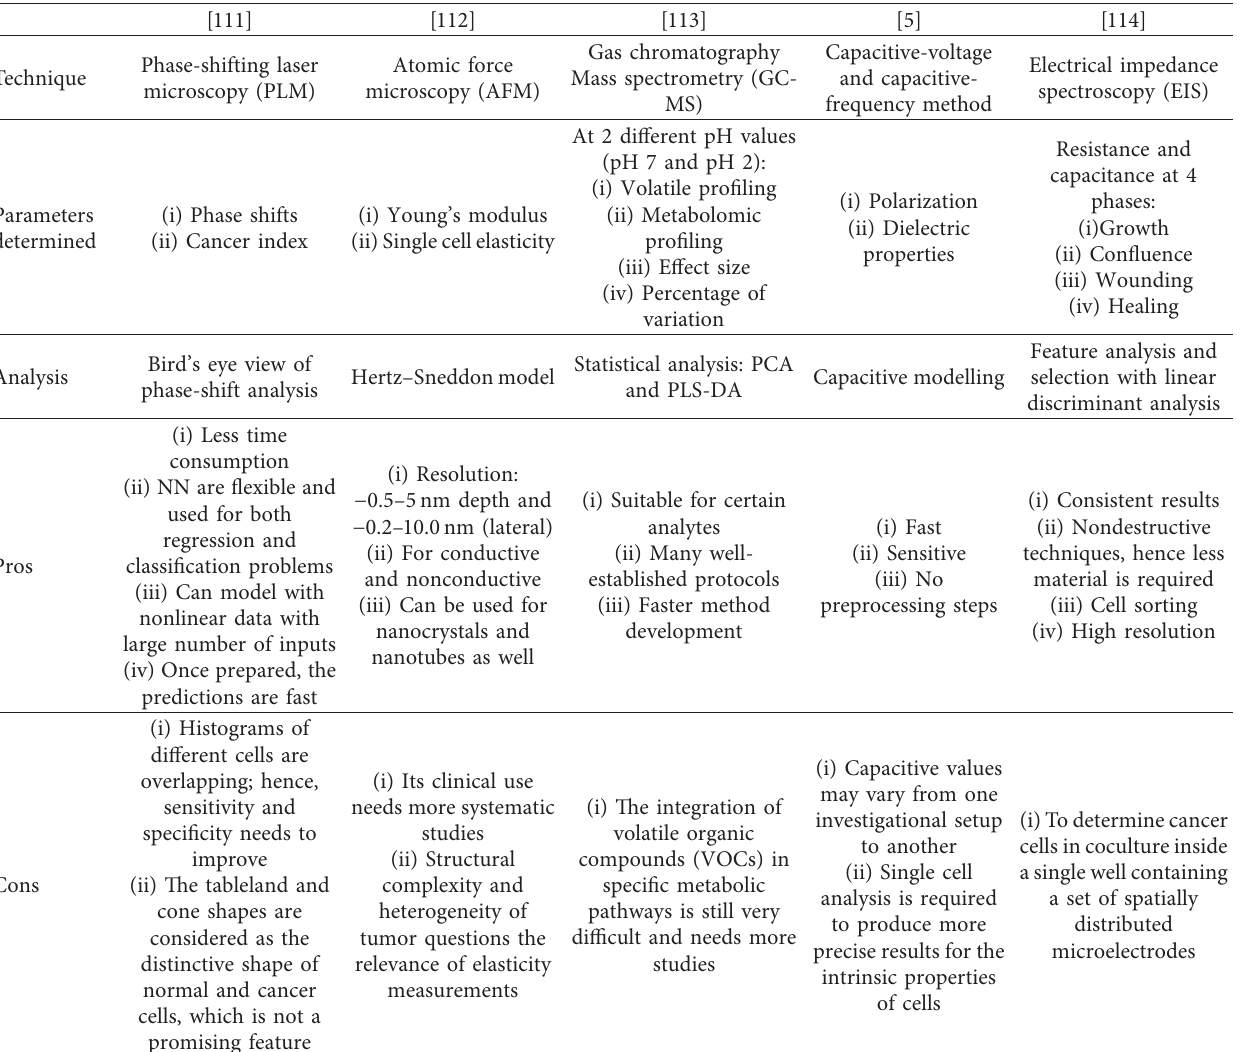
Figure 6: A schematic depicting how to derive the effective complex permittivity ε ∗ Table 5: Distinct electrical-based cancer cells detection